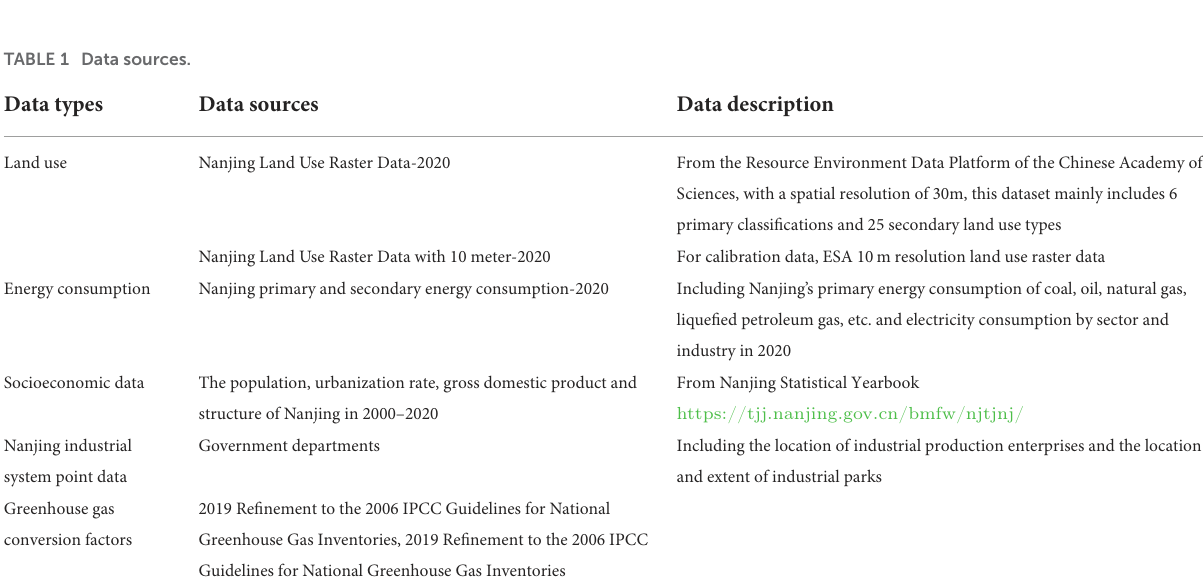
FIGURE4 The structure of GDP in Nanjing.